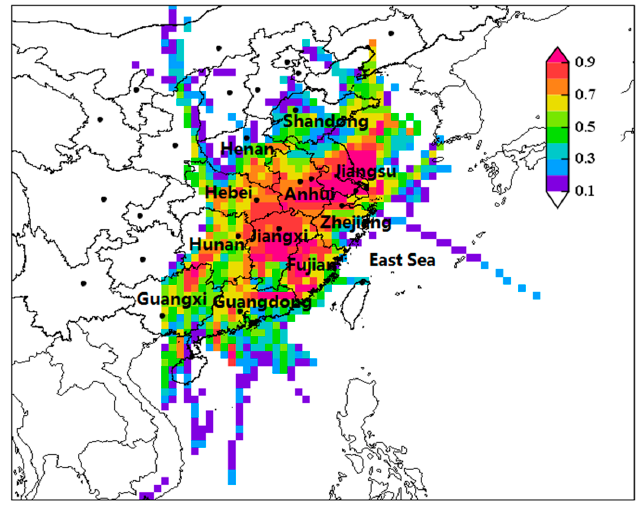
Figure 10. PM 2.5 potential source contribution distribution.